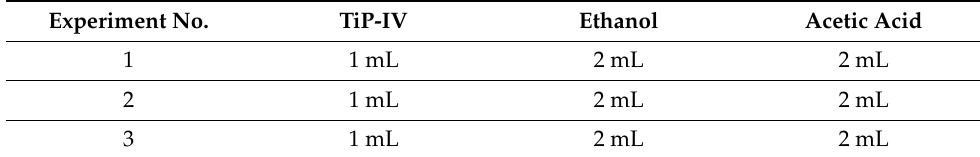
Table 2. TTIP solution